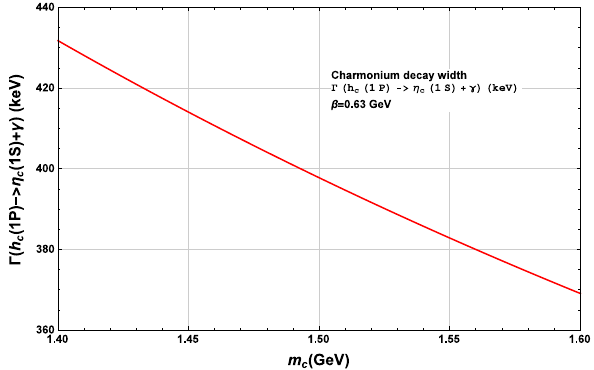
Fig. 3 Decay width for h c ( 1 P ) → η c ( 1 S ) + γ (keV) as a function of = 0 . 63 GeV m c in the LFQM, with β h c ( 1 P )(η c ( 1 S ))